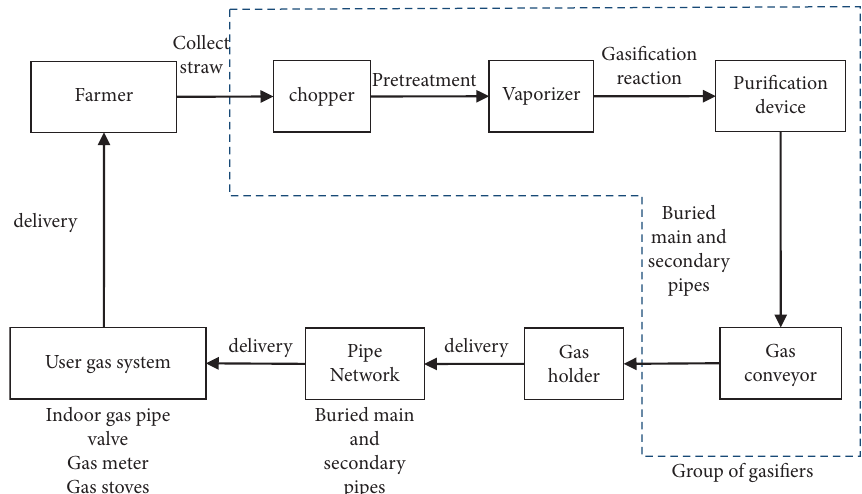
Figure 6: Planning flowchart of Chongqing rural straw gasification centralized gas supply mode. Chart source: the authors, organized according to relevant data.